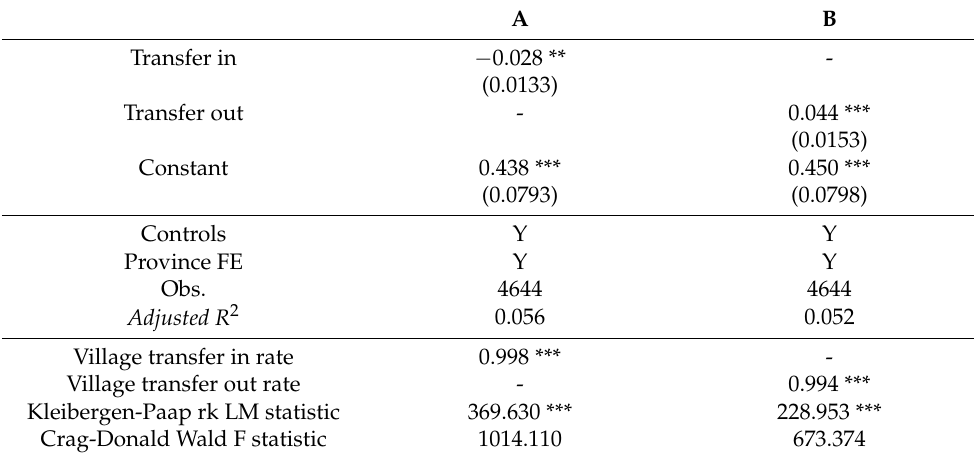
Table 5. 2SLS estimation